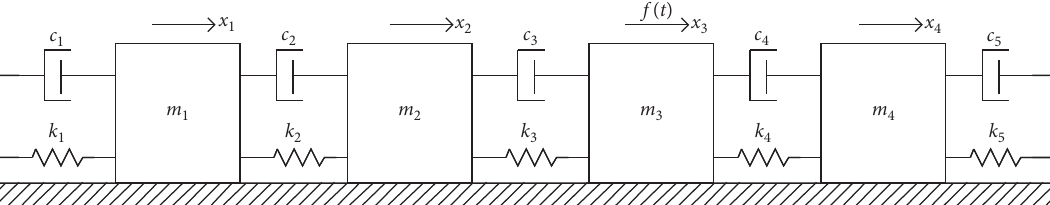
Figure 6: The 4-DOF numerical